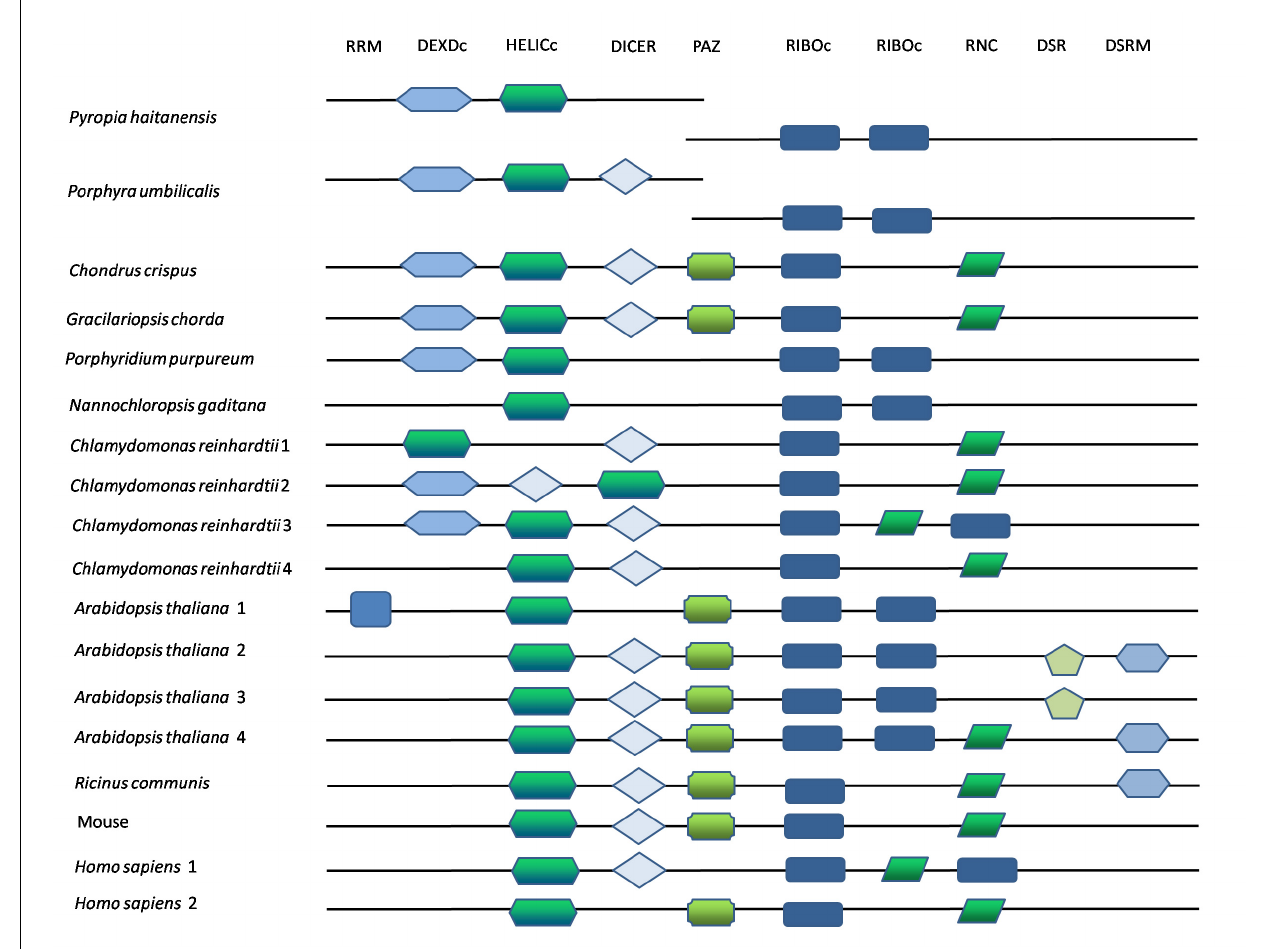
FIGURE 4 | Structural features of Dicers in P. haitanensis and other species. Each conserved domains were represented as different shapes. RRM, RNA recognition motif; DEXDc, DEAD-like helicase domain; HELICc, helicase C; RIBOc, Ribonuclease III C terminal domain; RNC, dsRNA-specific